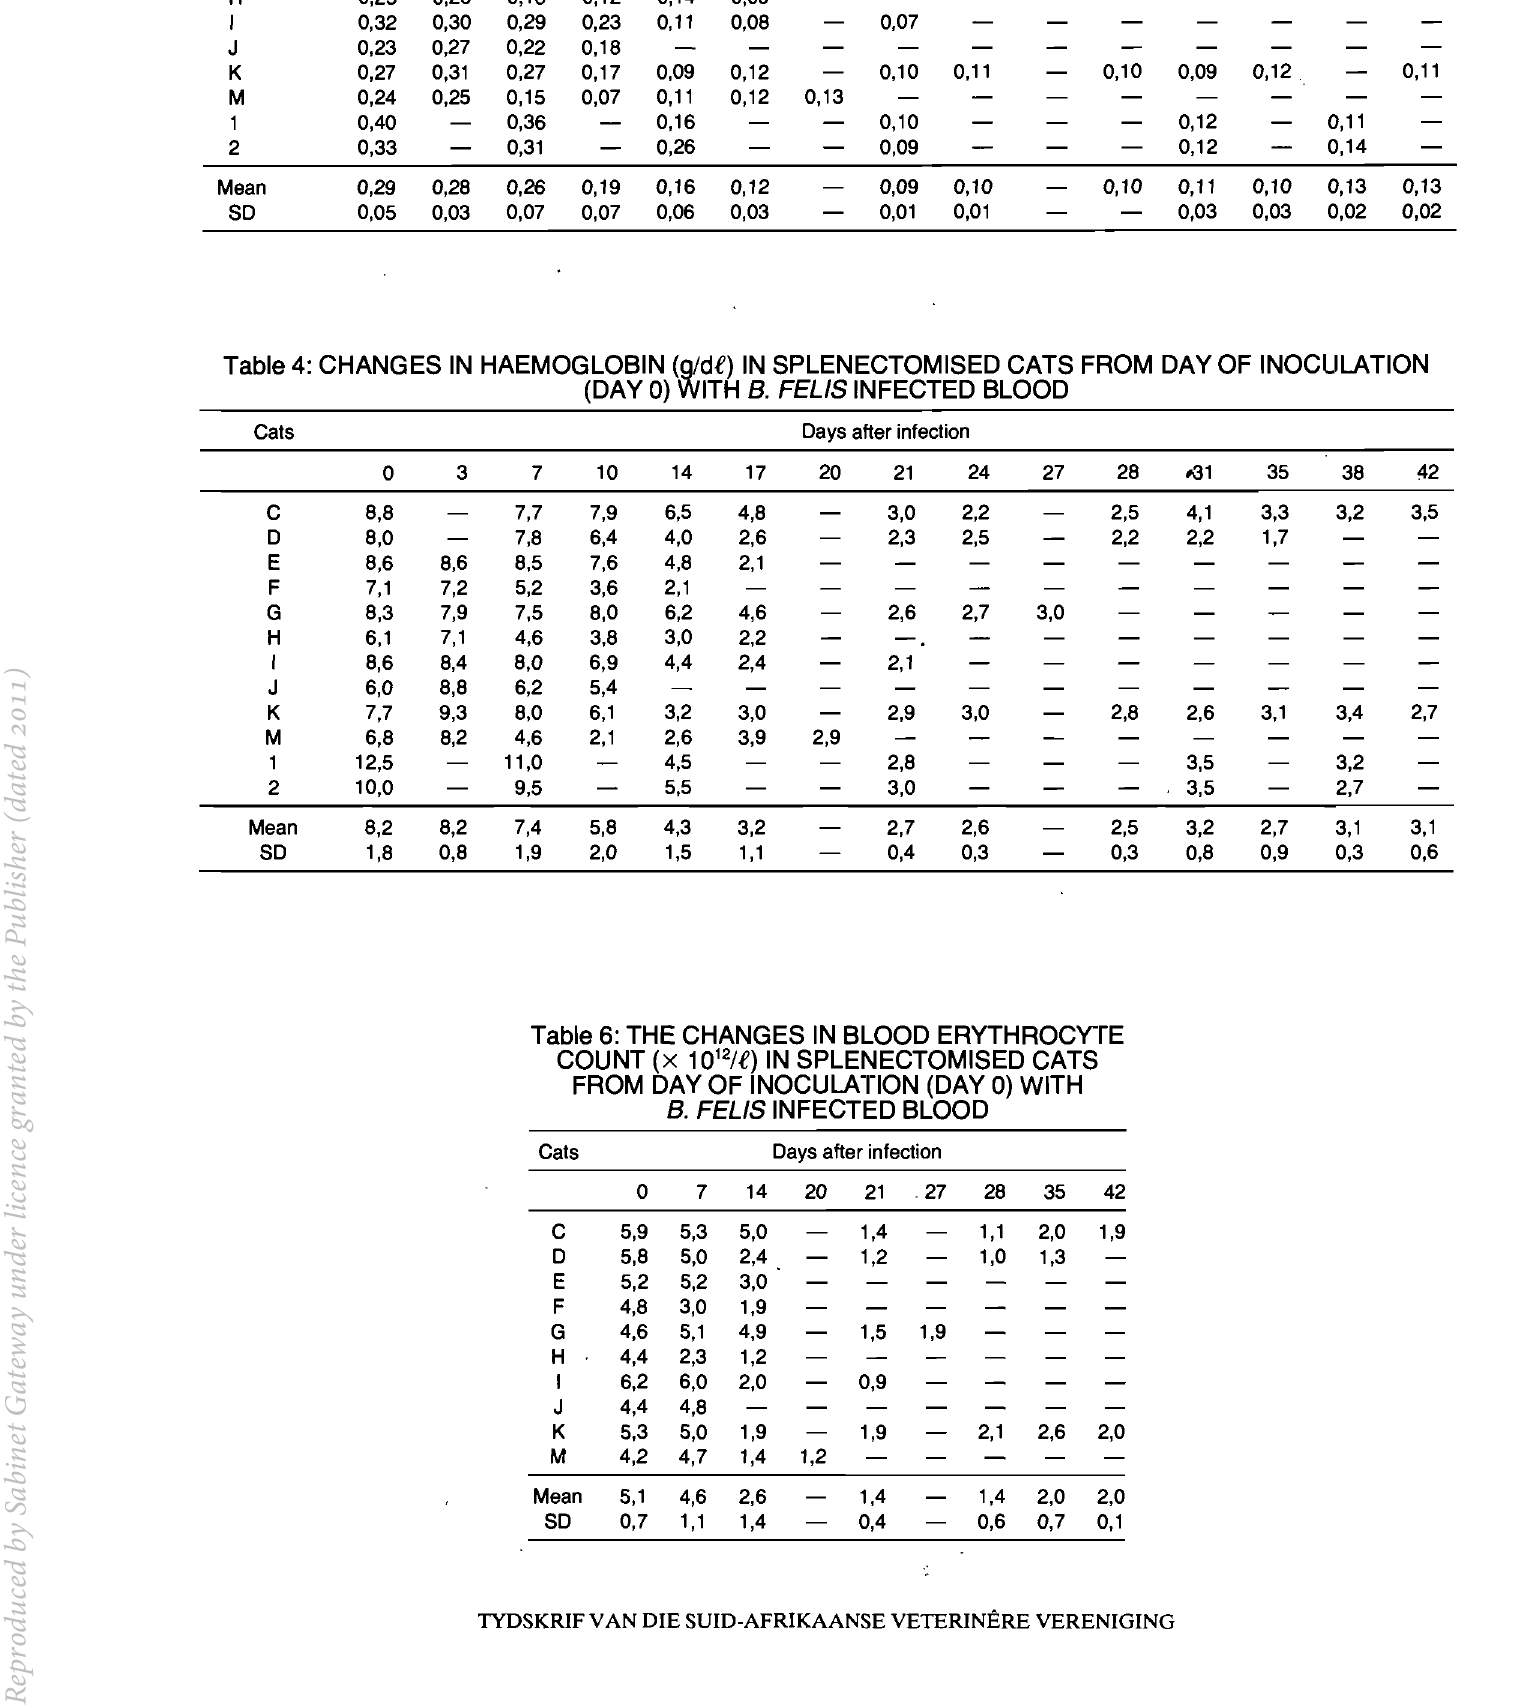
Table 4: CHANGES IN HAEMOGLOBIN (rvdf) IN SPLENECTOMISED CATS FROM DAY OF INOCULATION (DAY 0) ITH B. FELIS INFECTED BLOOD